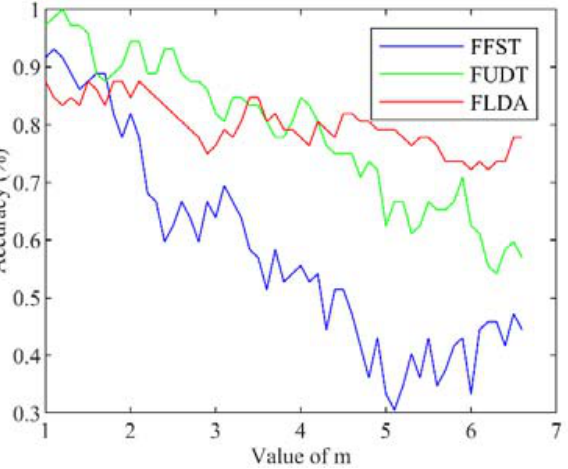
Figure 6. The accuracy rates on the test set when changing the value of weight exponent m.